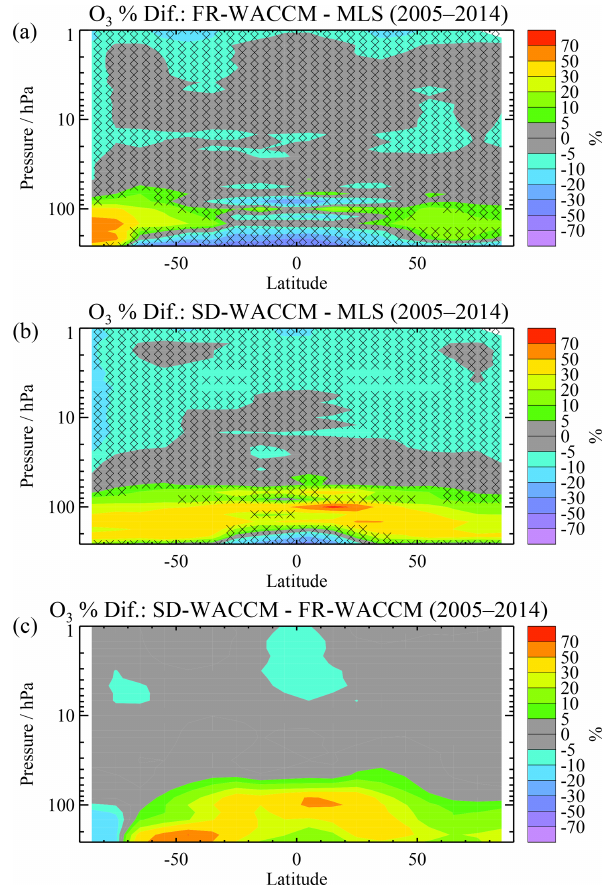
Figure 1. These latitude–pressure contour plots show percent dif- ferences (100 × (model-data) / data) for binned climatological O 3 from 2005 to 2014 (see Fig. S1 for the average MLS and model val- ues), for (a) the free-running model (average of three FR-WACCM realizations), (b) for the specified dynamics (SD-WACCM) ver- sion, and (c) for SD-WACCM – FR-WACCM. Regions that are not crossed out in (a) and (b) are regions where the model climatology differs quite significantly from the data, based on a comparison of the ratio of (absolute) model–data differences to MLS systematic error estimates (see